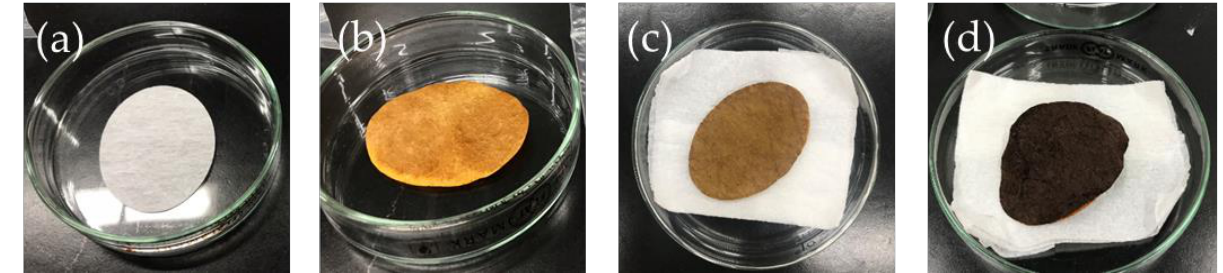
Figure 6. Color change of MNWF depending on the degree of grafting ( a ): dg 100% GMA MNWF, ( b ): dg 100% 4-AMP MNWF, ( c ): dg 170% 4-AMP MNWF, ( d ): dg 200% 4-AMP MNWF.